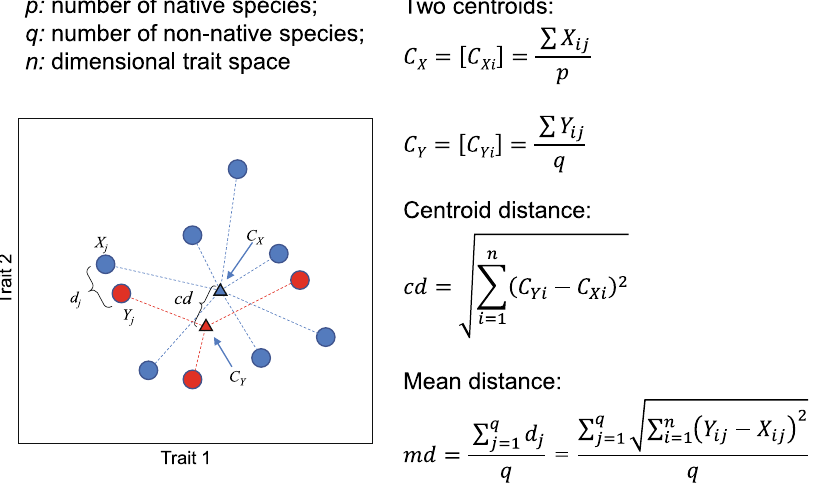
Fig.1|Anexampleshowinghowcentroiddistance( cd )andmeandistance( md ) are computed. The p and q individual native and non-native fi sh species in a n - dimensionaltrait space(here n =2) are representedby blue and red circles. Vector Y j represents the position of non-native species j and vector X j is the position of its nearestnative species. d j isthe distancebetween X j and Y j . md isthe meandistance between all non-native species and their nearest native neighbors. C X and C Y